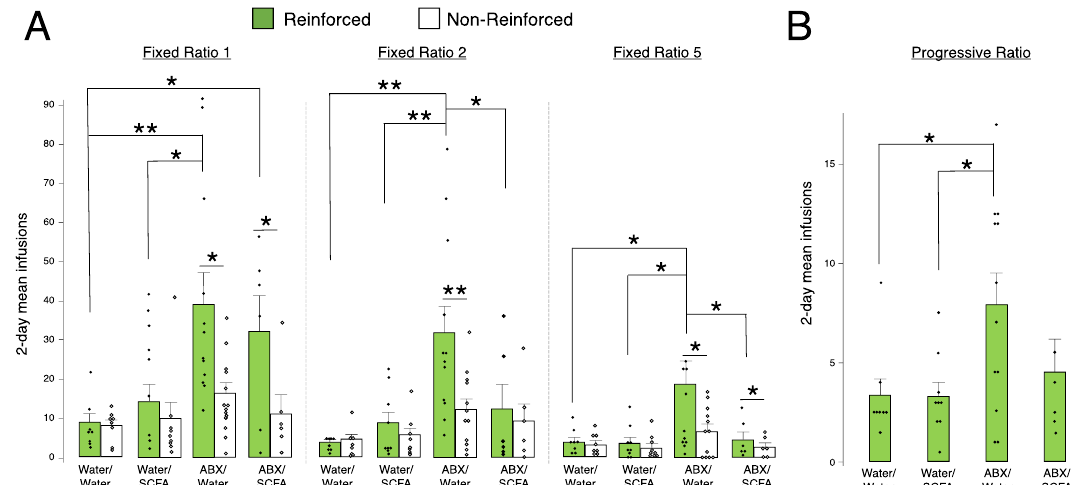
Figure 5. Fentanyl intravenous self-administration after short-chain fatty acid (SCFA) supplementation. All animals self-administered a fentanyl dose of 1.25 µ g/kg/infusion and were treated with water, SCFA, antibiotics (ABX), or ABX plus SCFA. ( A ) Mean number of infusions across days 4–5 at fixed ratios 1, 2, and 5. Infusions were administered via nose pokes and are reported as reinforced (filled bars and circles) and non-reinforced (empty bars and circles) responses. Error bars represent S.E.M., ** p < 0.01, * p < 0.05, n = 6 – 12/group. ( B ) Mean number of infusions across 2 days at progressive ratio. Error bars represent S.E.M., * p < 0.05, n = 6 – 12/group.